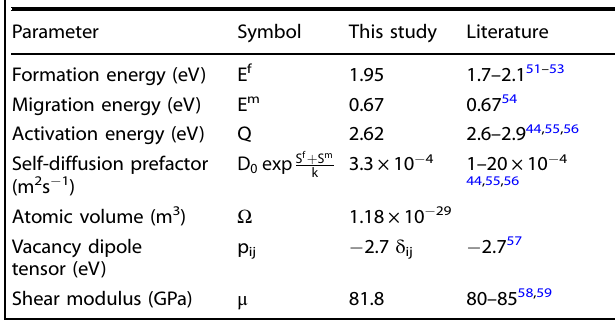
Table 2. DDD Simulation